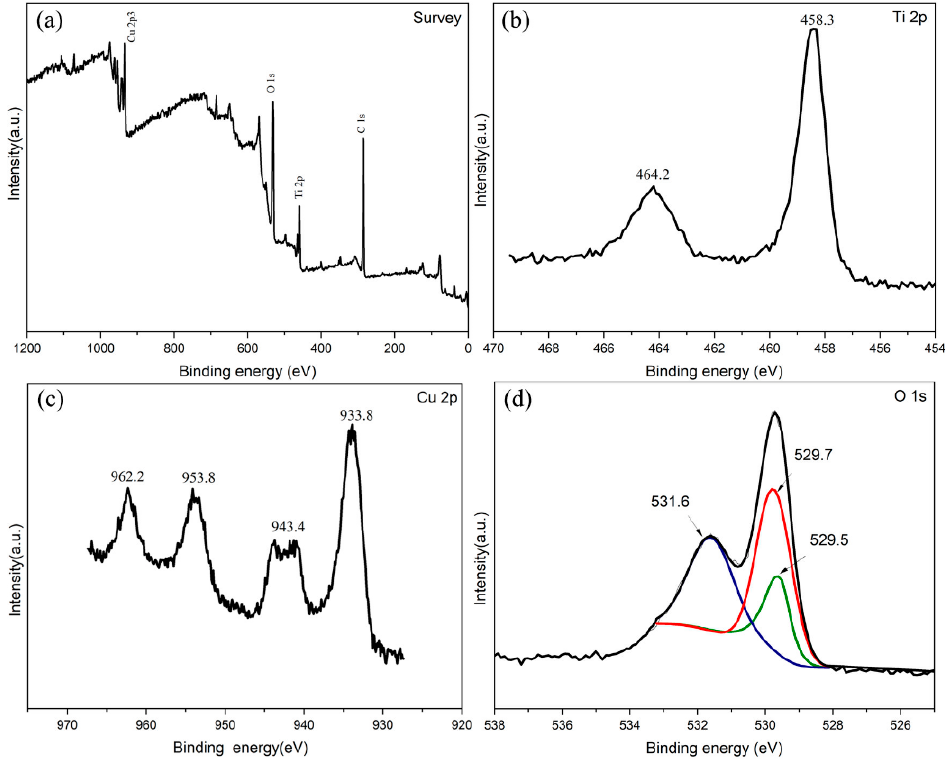
Figure 3. XPS spectra of ( a ) sample surface, ( b ) Ti 2p, ( c ) Cu 2p and ( d ) O 1s of CuO-TiO 2 nanocomposites.